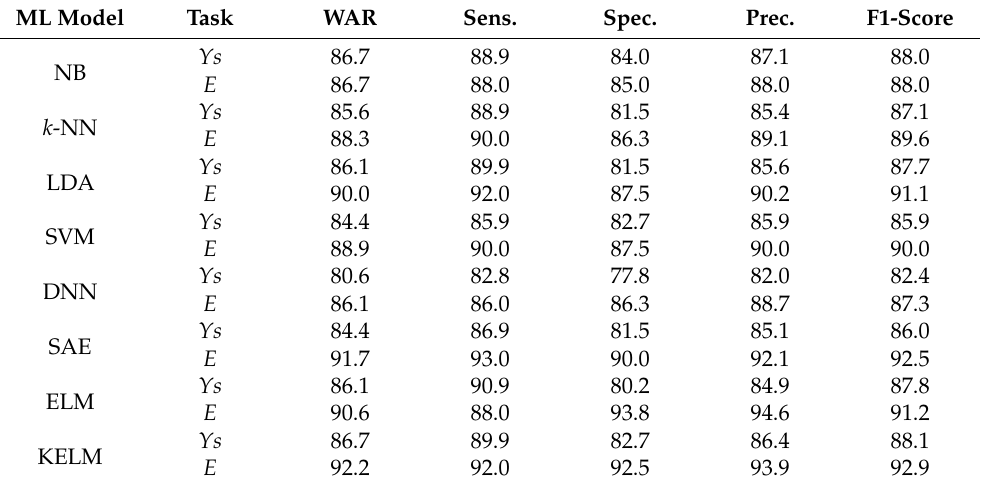
Table 1. The results of the ML models on test set by complementary evaluation metrics (in [%]). ML Model Task WAR Sens. Spec. Prec.